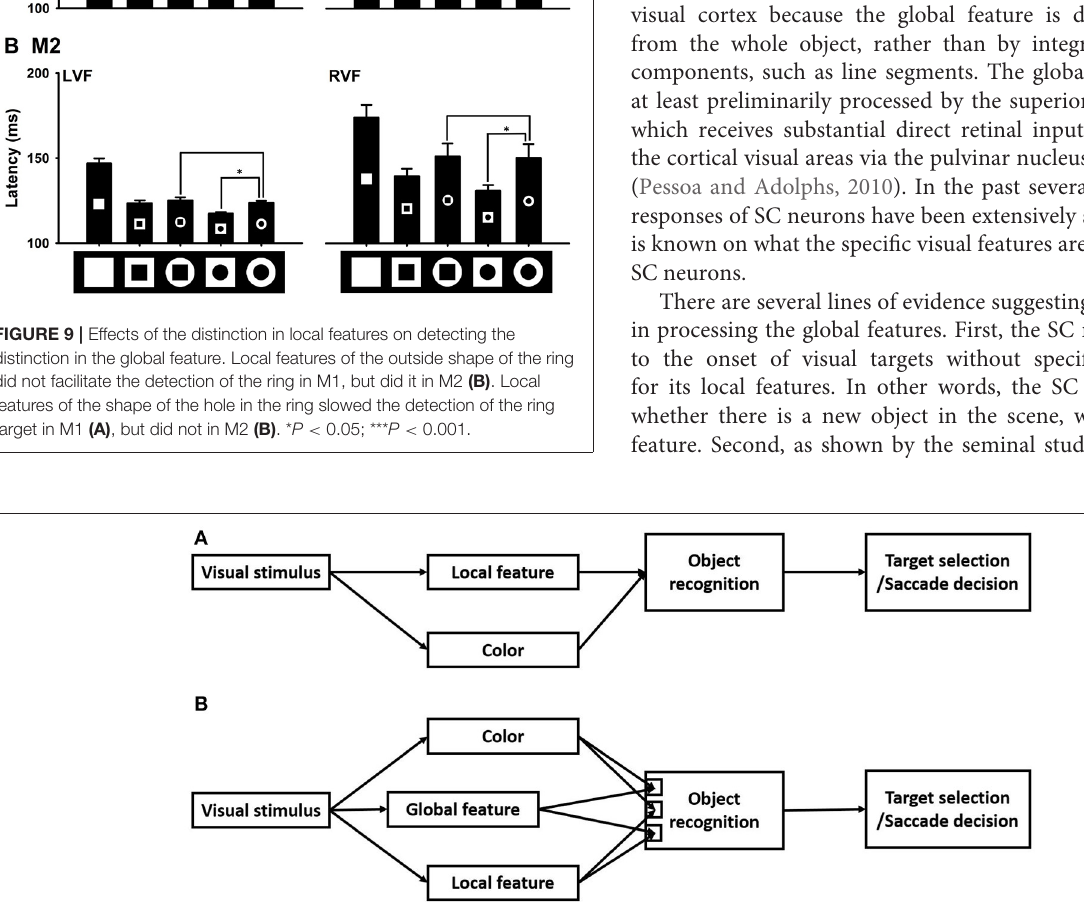
Frontiers in Neuroscience |